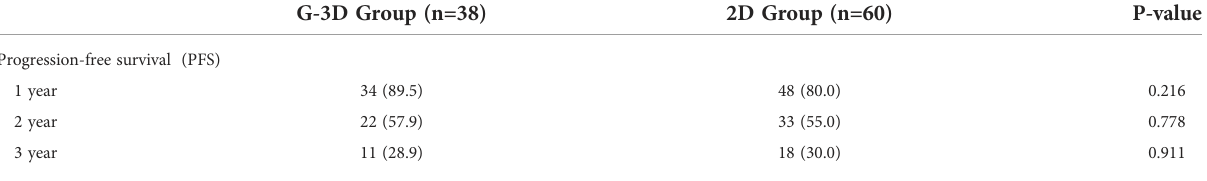
TABLE 3 The survival time of two groups